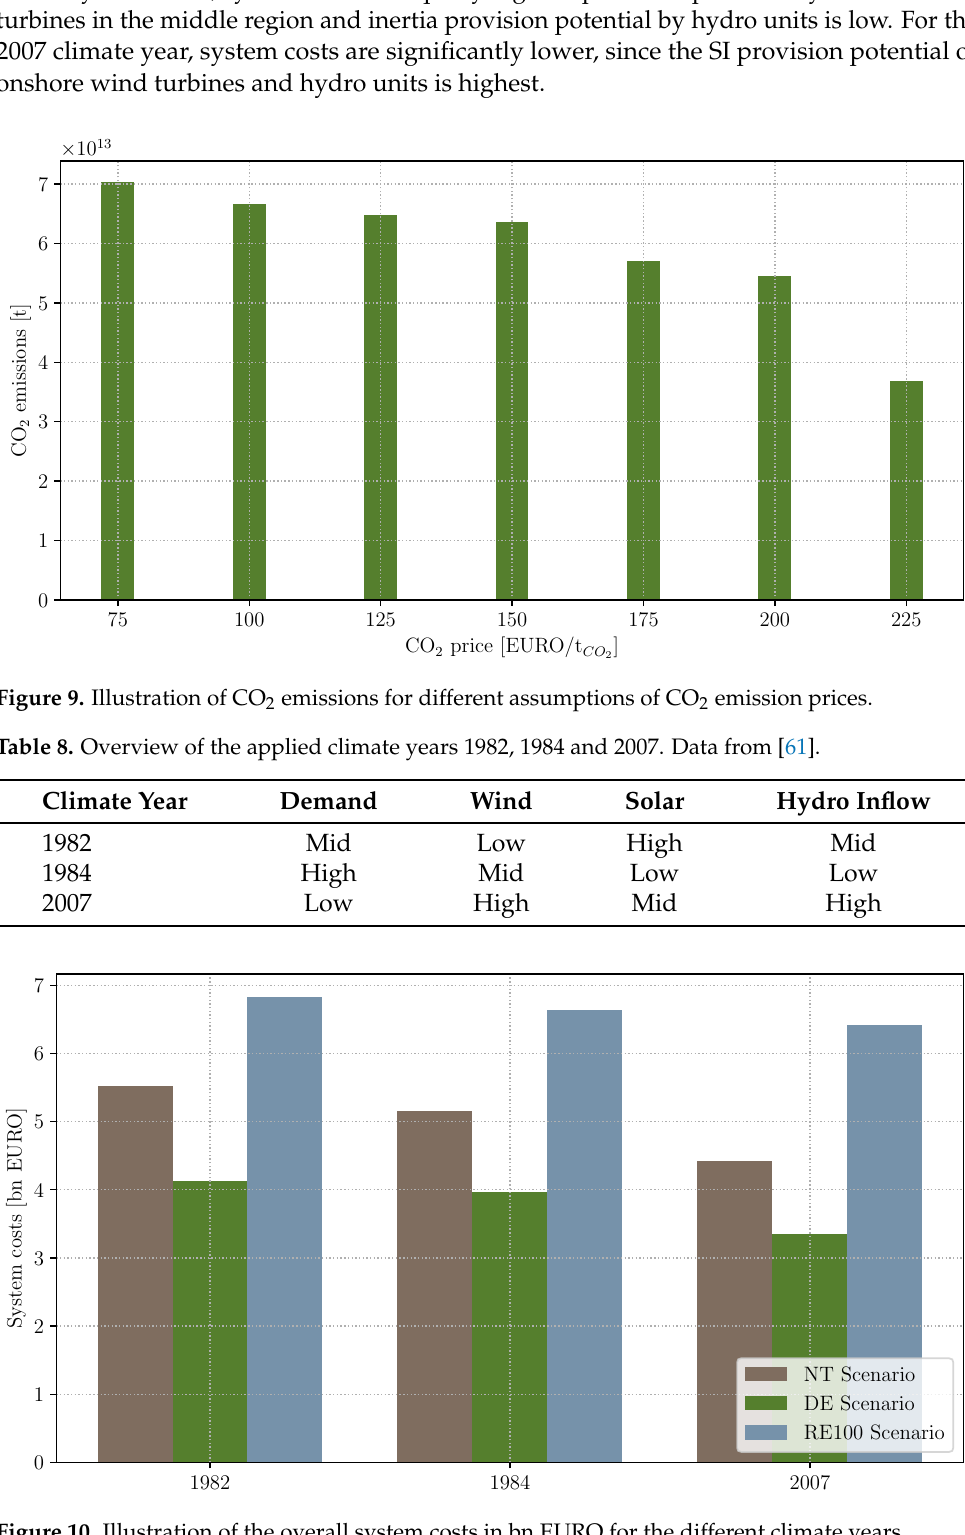
Figure 10. Illustration of the overall system costs in bn EURO for the different climate